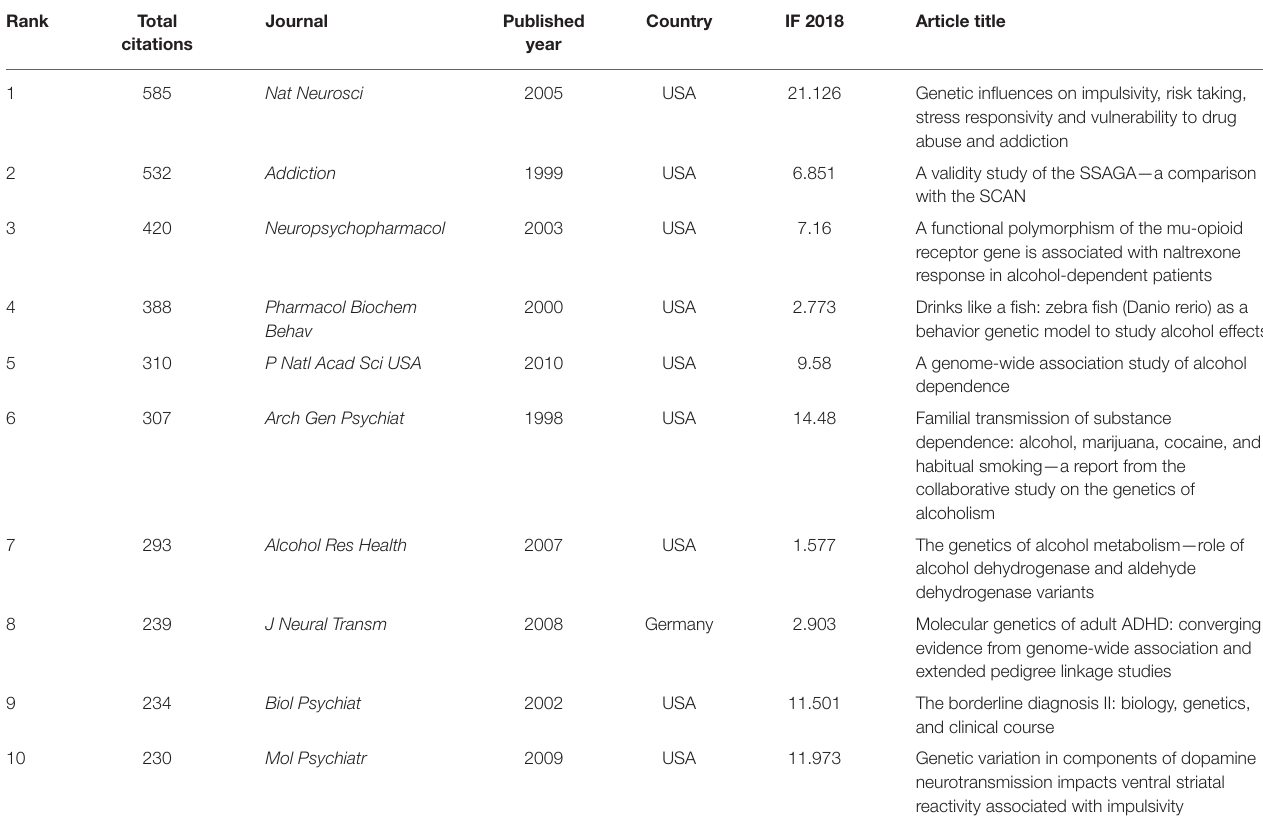
TABLE 3 | The characteristics of the highly cited and the most impactful classic